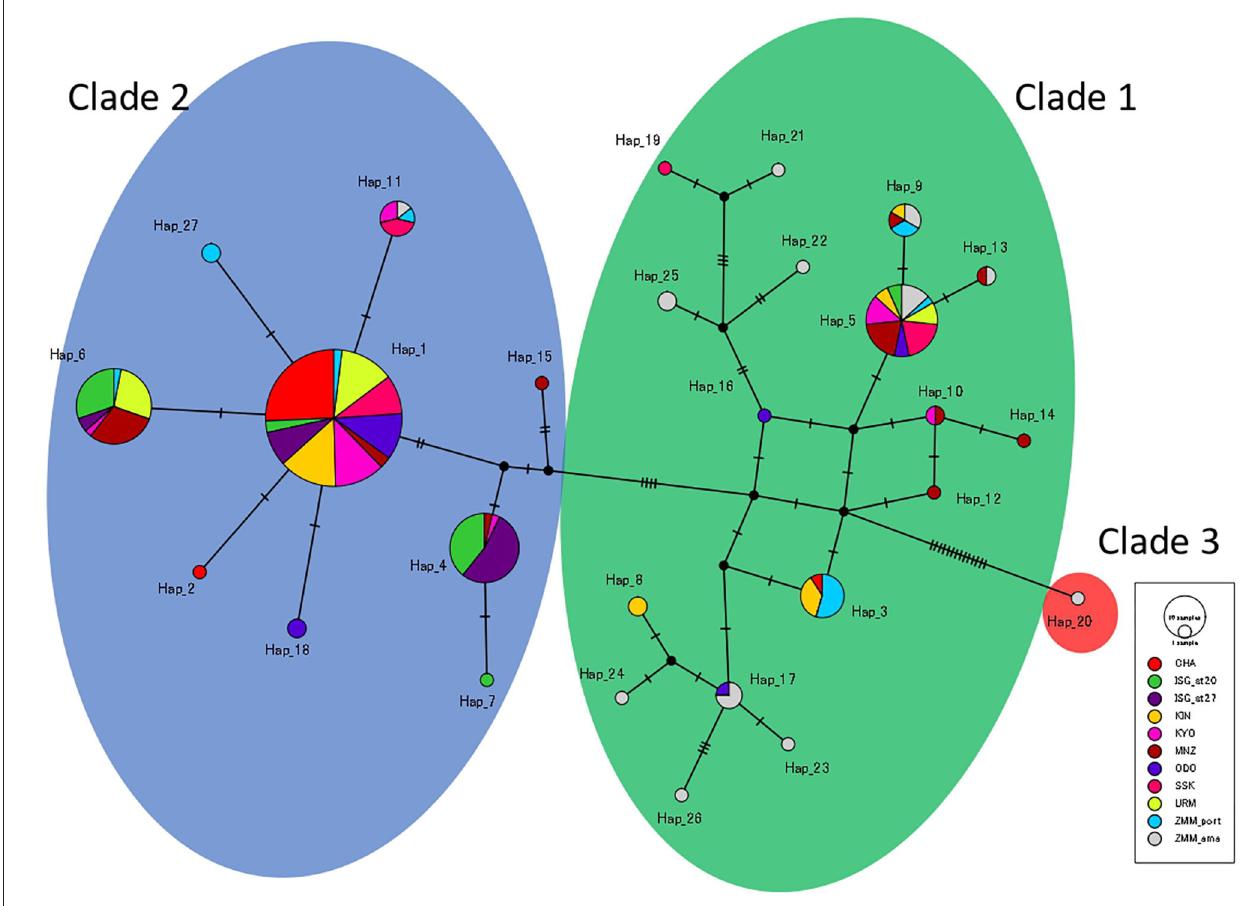
FIGURE 5 | Median joining haplotype network based on COI sequences of H. atra . Each circle indicates haplotype with colors indicating the different locations. The size of each circle indicates the number of individuals included in each haplotype. Background colors show clades (green: clade 1, blue: clade 2, red: clade